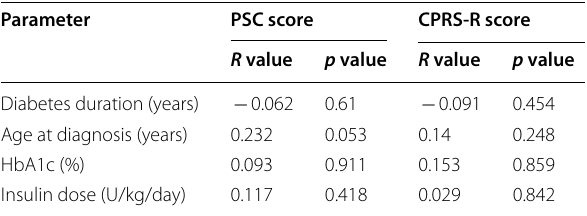
PSC Pediatric Symptom Checklist, IQR interquartile range Table 3 Correlation between the different parameters related to diabetes and the scores on the different psychometric assessment